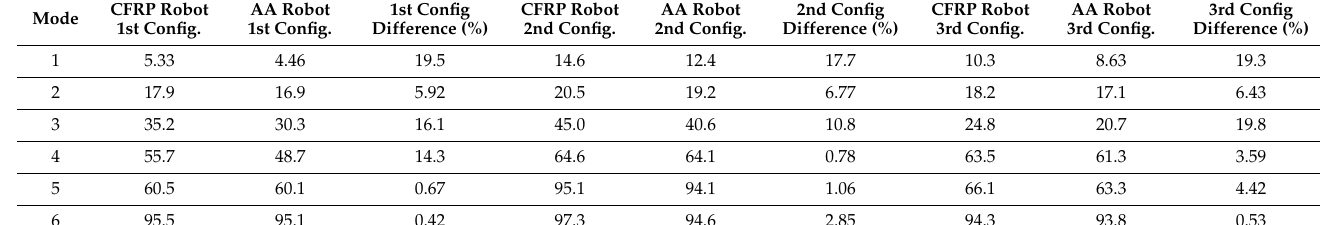
Table 8. Natural frequencies of the AA and CFRP manipulators under three configurations (Hz).